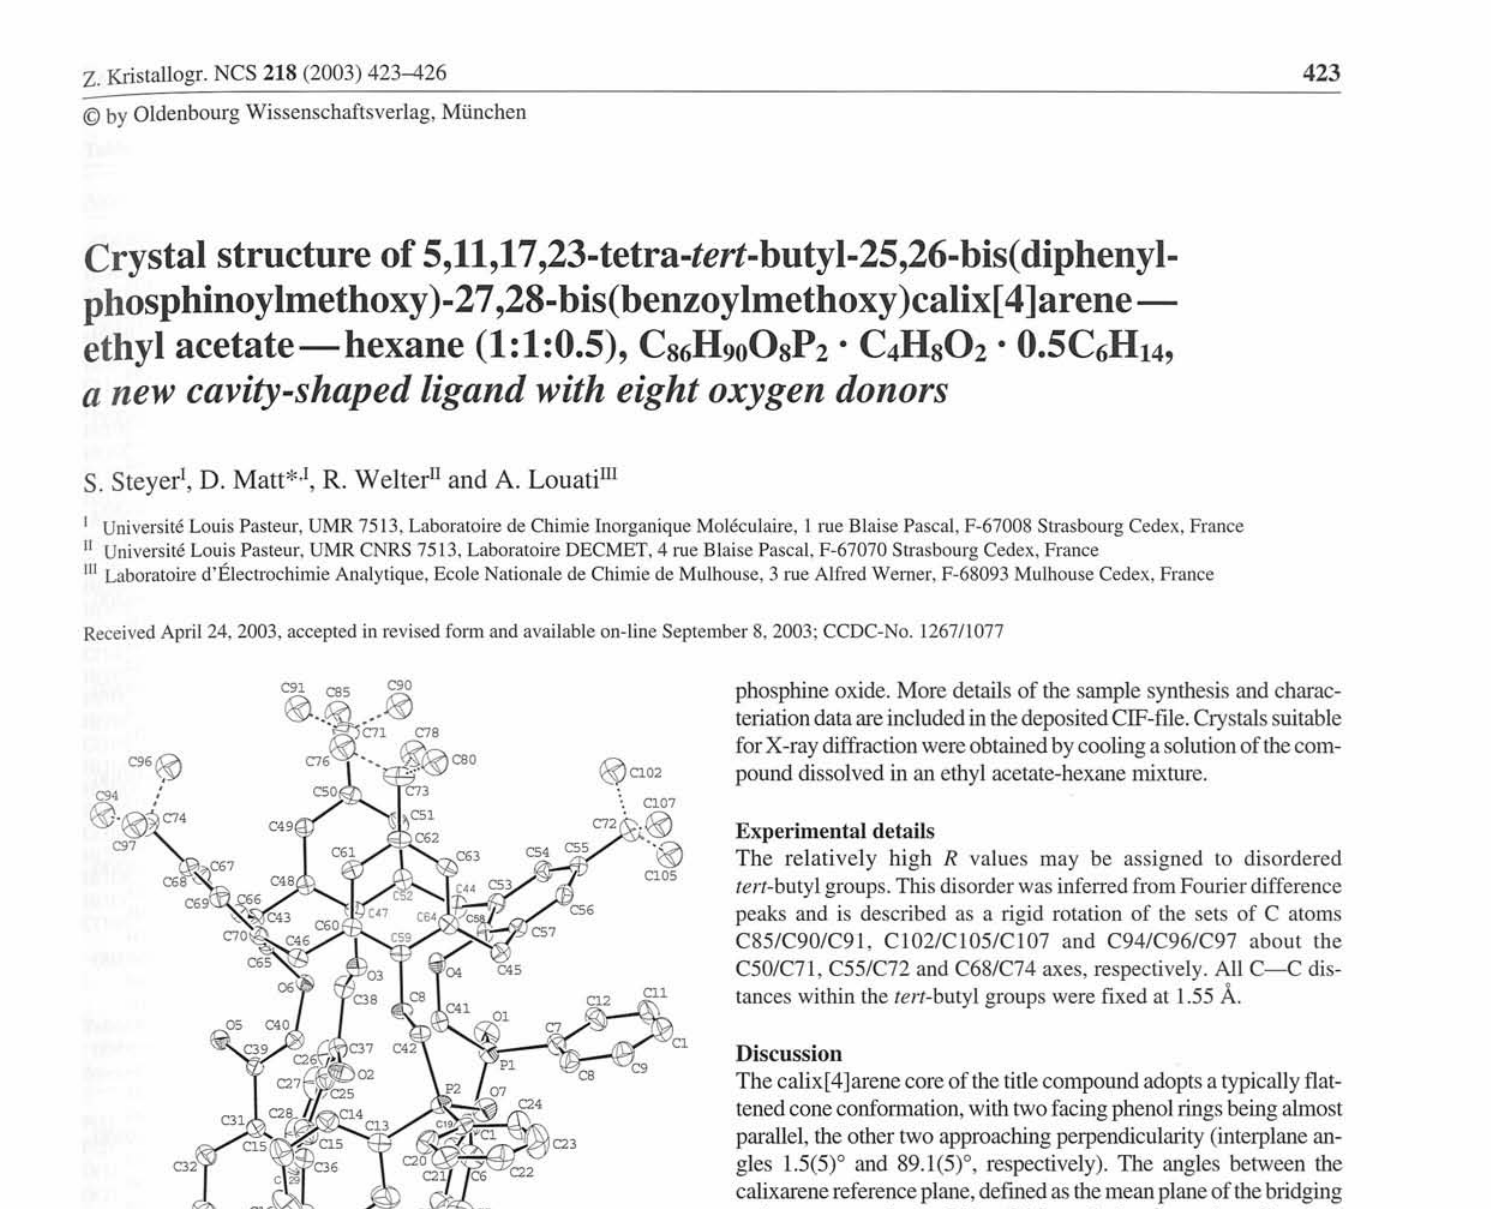
Table 1. Data collection and